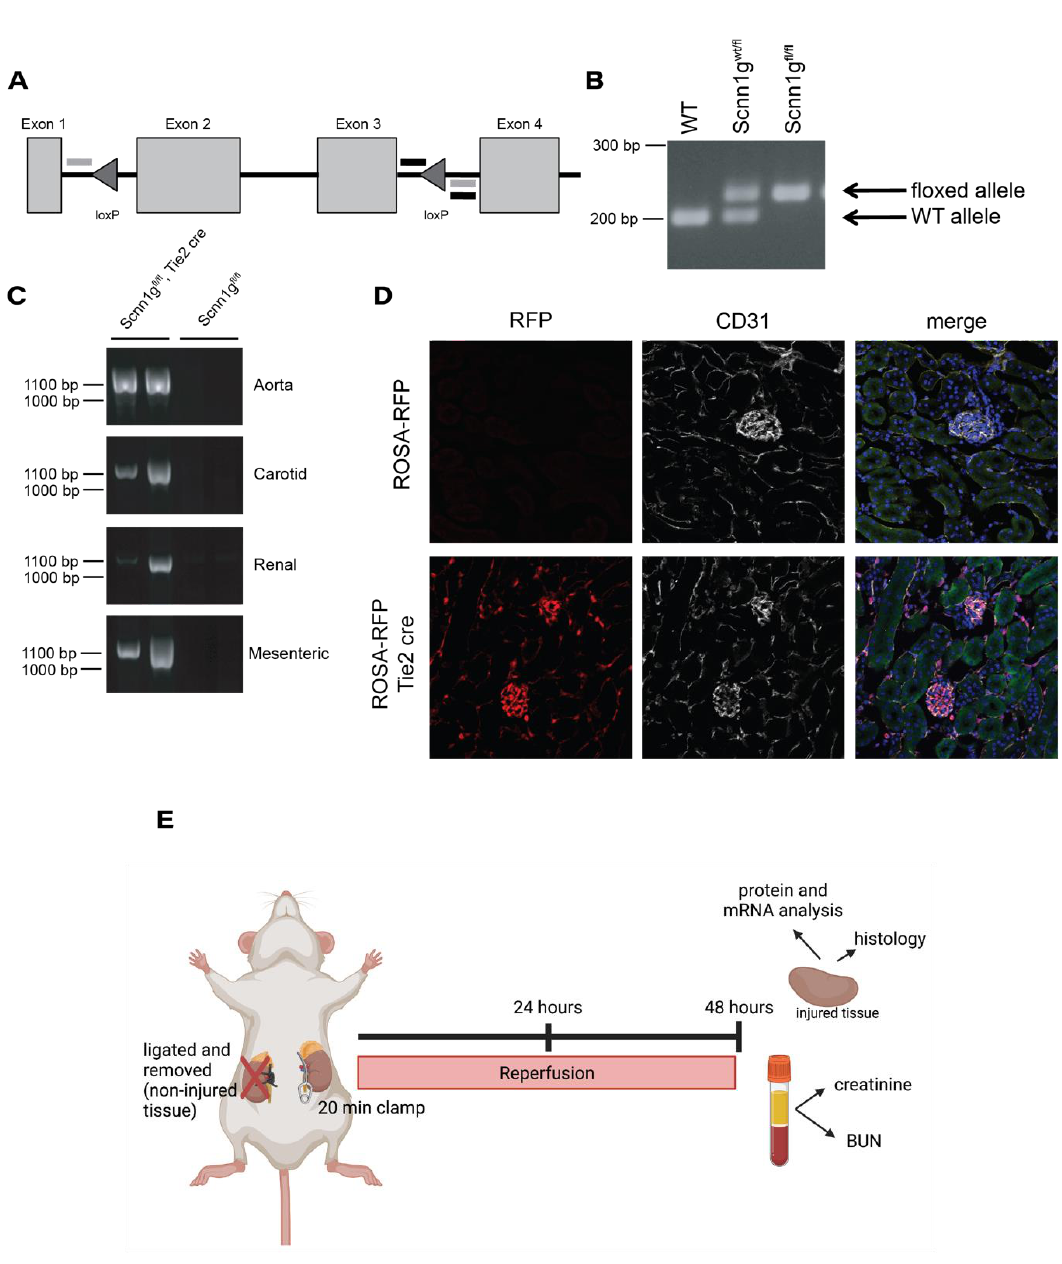
Figure 1. Design and validation of a mouse model with loxP insertions in the γ subunit of ENaC. ( A ) Tissue specific KO of the γ subunit of ENaC was achieved through creation of a mouse containing two loxP sites surrounding the second and third exons of the Scnn1g gene. Genotyping primers were designed that flanked the second loxP site (designated by black, horizontal lines) and primers were also developed to validate successful excision (designated by gray horizontal lines). ( B ) Genomic DNA isolated from mouse tail snips were added to PCR reactions containing genotyping primers. WT animals had only a lower ~200 bp whereas insertion of the loxP site was indicated by an upward shift to ~230 bp. Heterozygous animals (Scnn1gwt/fl) displayed both bands while homozygous animals (Scnn1gfl/fl) had only the upper band. ( C ) Aorta, carotid, renal and mesenteric arteries were isolated from Scnn1gfl/fl animals with or without expression of an endothelial specific cre under the Tie2 promoter. DNA was extracted and added to a PCR reaction with excision validation primers. Presence of a product is seen only in cre-expressing animals. ( D ) Kidneys from Tie2 cre animals crossed to a ROSA-RFP reporter mouse denote cre-expressing cells in red. An antibody to the endothelial marker CD31 is shown in white with green autofluorescence marking the tissue outline and blue DAPI staining showing the location of nuclei. ( E ) Schematic of experimental procedure showing that at the time of surgery, the left renal vasculature was clamped for 20 min and the right kidney was ligated and removed. Reperfusion was allowed for 48 h before the animals were sacrificed and downstream analysis